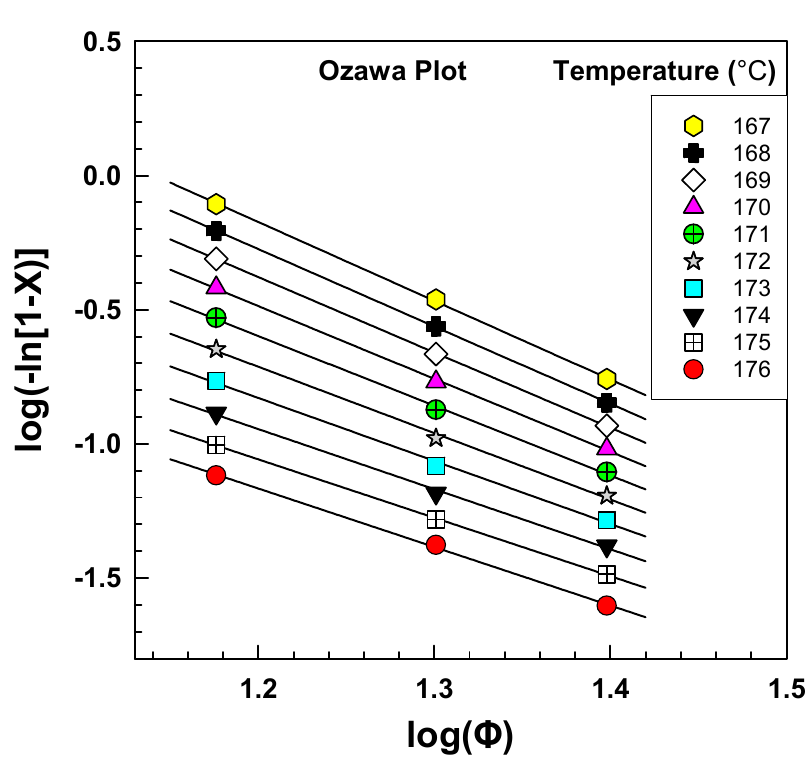
Figure 8. DSC results from the Ozawa plot for PA6.